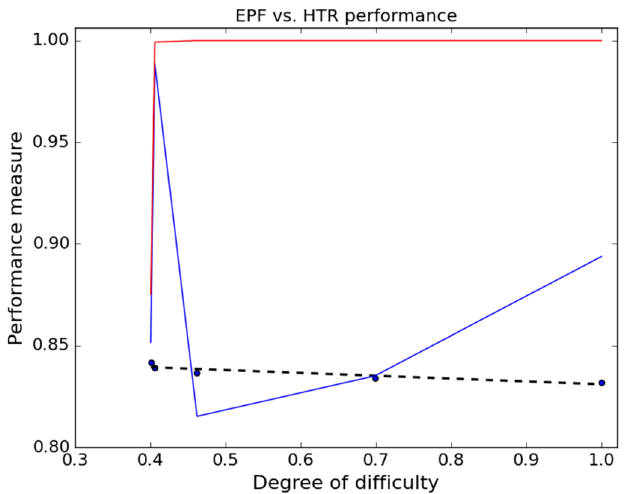
Figure 14. EPF vs. HTR performance in blue and red (respectively). In black: the fitted line defines the accepted limits of the performance measure.